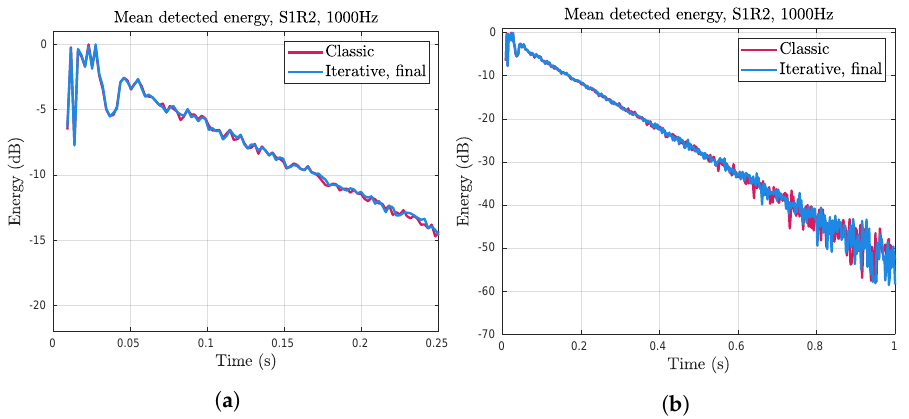
Figure 7. The mean detected energy in the impulse response for the classical and iterative algorithms, the first 0.25 s of the impulse response in ( a ) and the first 1 s ( b ). The results are very